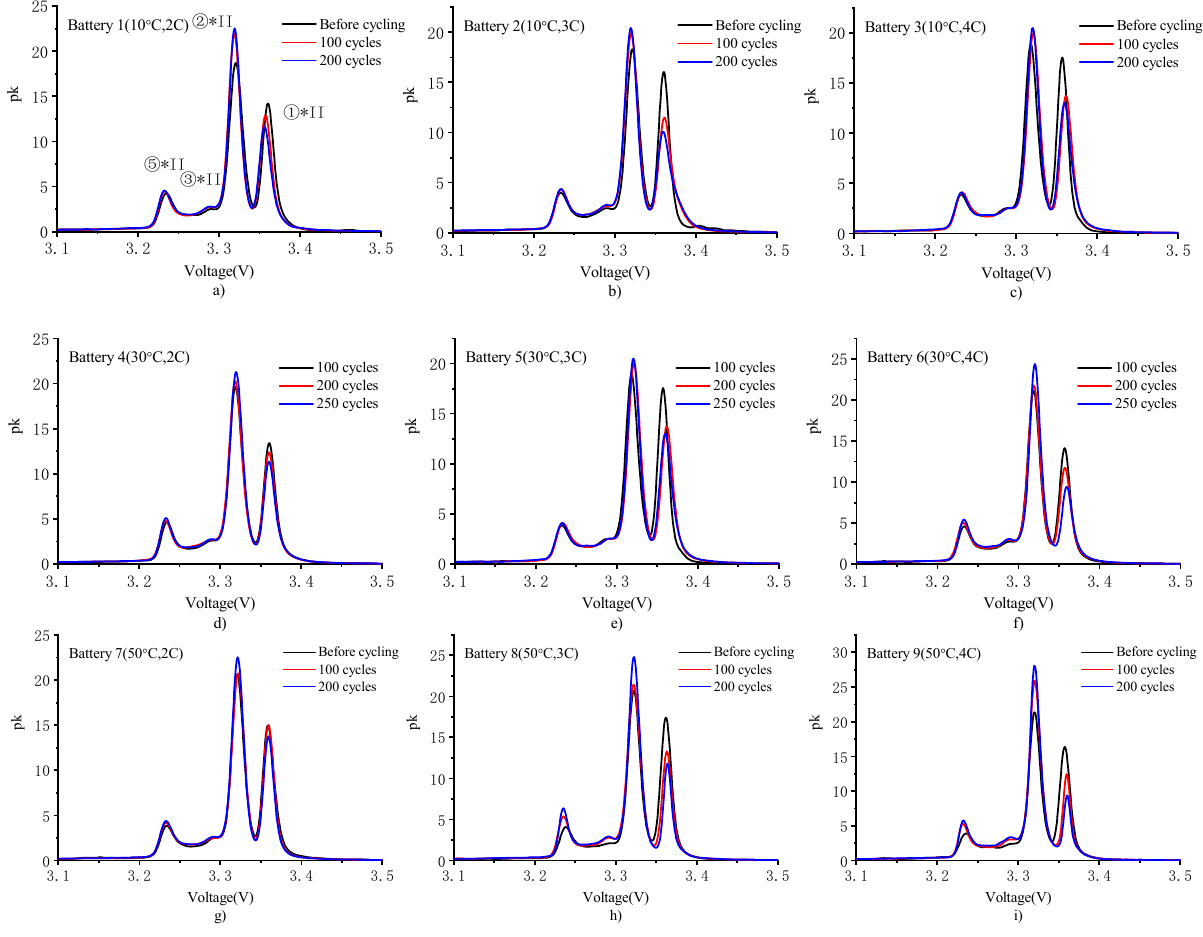
Figure 9. Changes in the PDF curves. ( a ) Change in PDF curve during cycle at 10 ◦ C and 2C charge rates; ( b ) Change in PDF curve during cycle at 10 ◦ C and 3C charge rates; ( c ) Change in PDF curve during cycle at 10 ◦ C and 4C charge rates; ( d ) Change in PDF curve during cycle at 30 ◦ C and 2C charge rates; ( e ) Change in PDF curve during cycle at 30 ◦ C and 3C charge rates; ( f ) Change in PDF curve during cycle at 30 ◦ C and 4C charge rates; ( g ) Change in PDF curve during cycle at 50 ◦ C and 2C charge rates; ( h ) Change in PDF curve during cycle at 50 ◦ C and 3C charge rates; ( i ) Change in PDF curve during cycle at 50 ◦ C and 4C charge